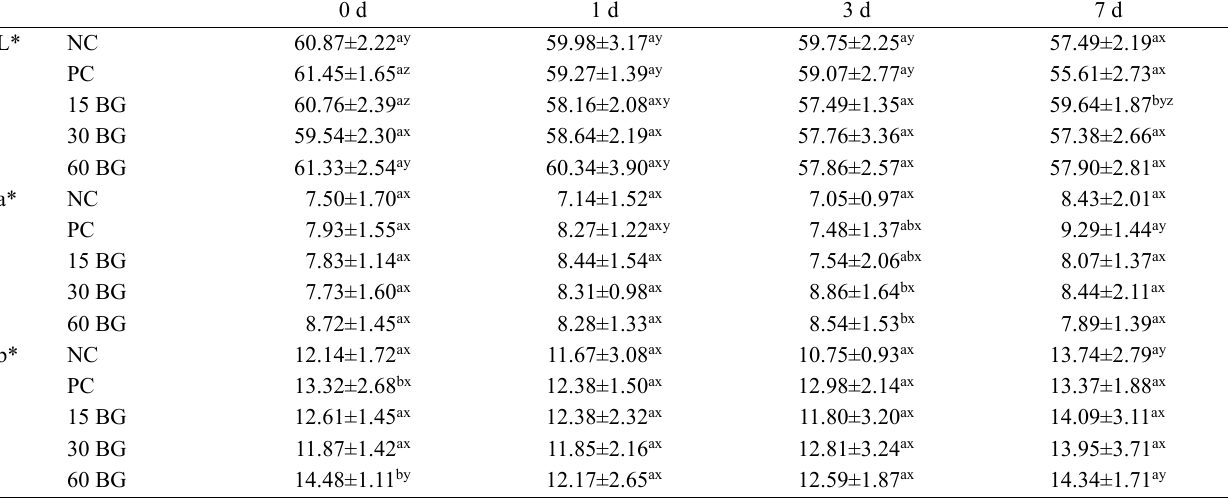
Table 4. Dietary effects of β-glucan on the meat color quality in broiler